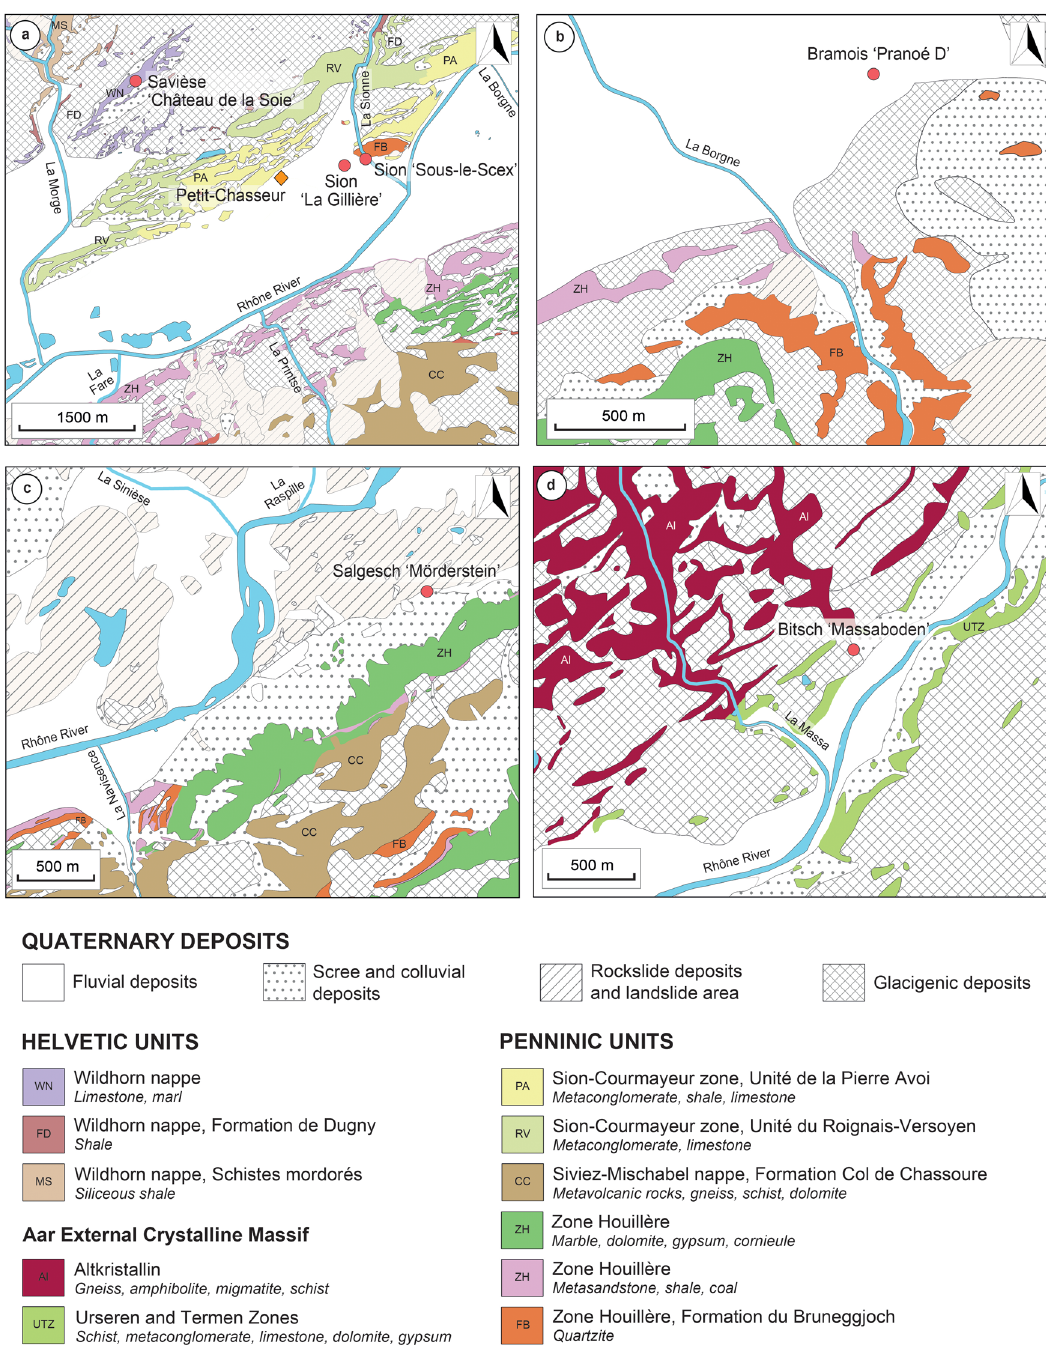
Figure 10: Geological maps of the areas in which the prehistoric settlements are located: ( a ) area where the sites of Savièse, 'Château de la Soie', Sion, 'Sous - le - Scex', and Sion, 'La Gillière'; ( b ) area of Bramois, 'Pranoé D'; ( c ) area of Salgesch 'Mörderstein'; ( d ) area of Bisch 'Massaboden'. The outcropping areas of the main rock types cited in the text are marked by distinct colors to show their exact location and distance from the archaeological sites. Modi fi ed after the data provided by the Swiss Federal O ffi ce of Topography ( https://map.geo.admin.ch/ )